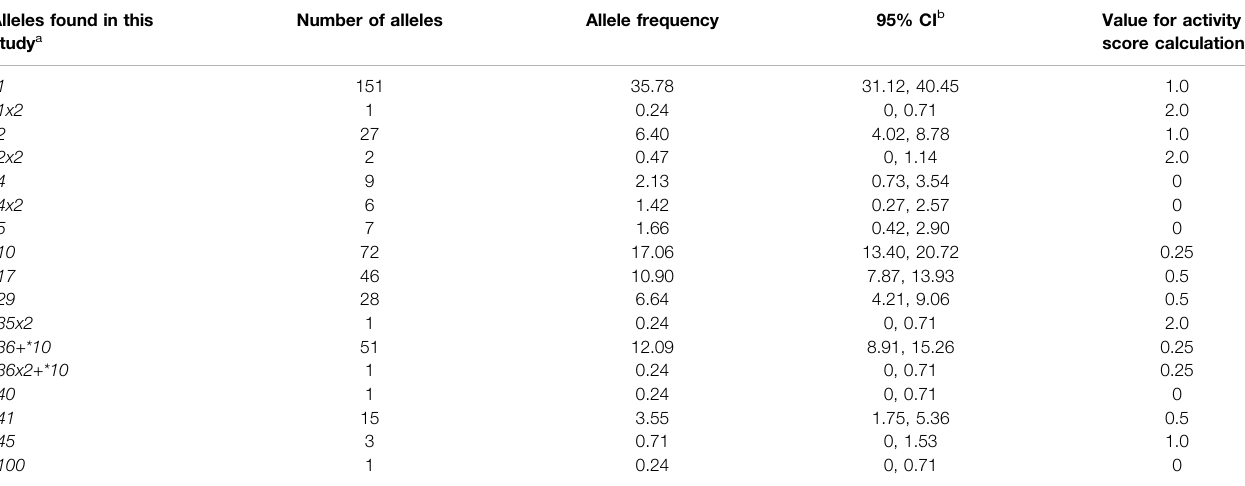
Number of alleles Allele